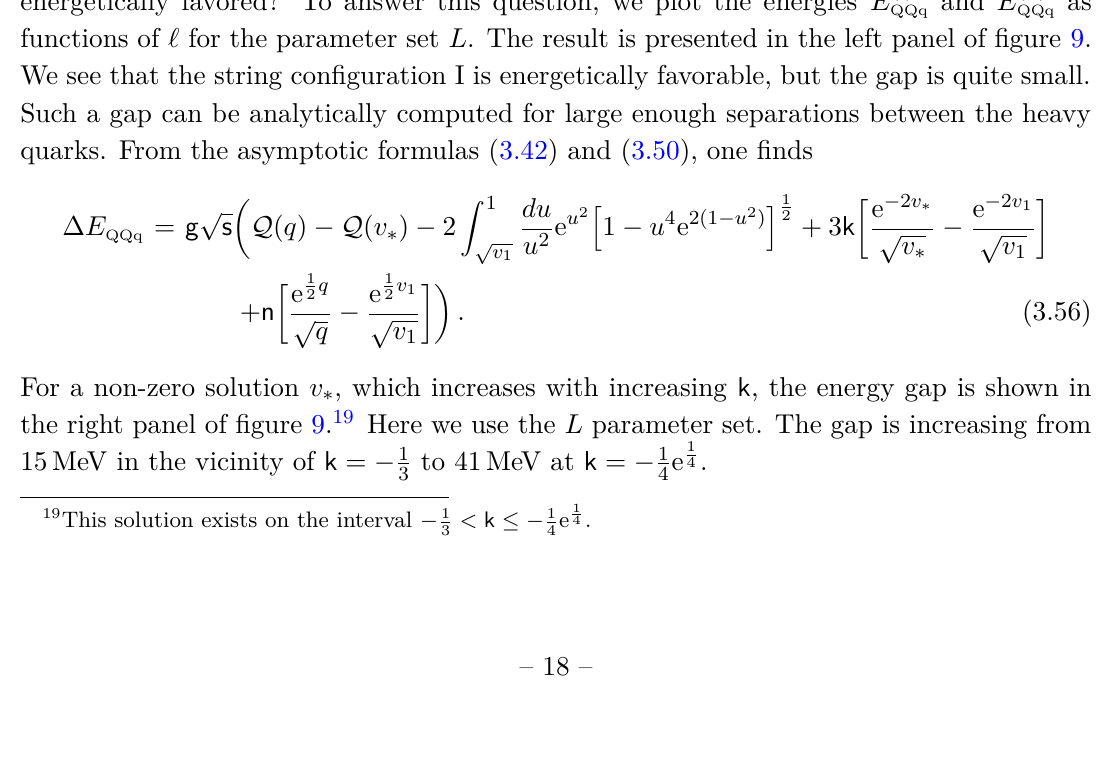
(solid curve) and E [Qq]Q e 1 4 4